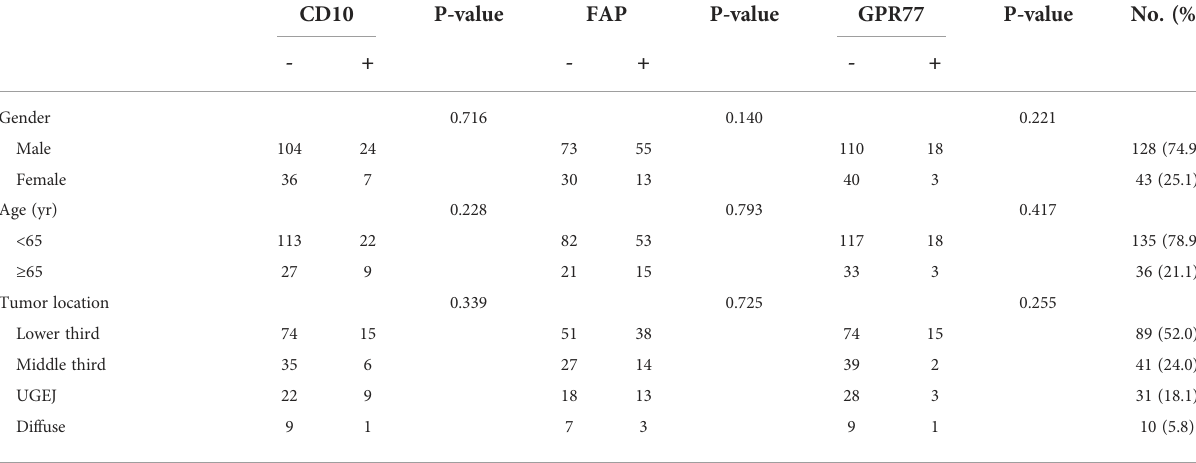
TABLE 1 Correlation between biomarkers after treatment and clinicopathological